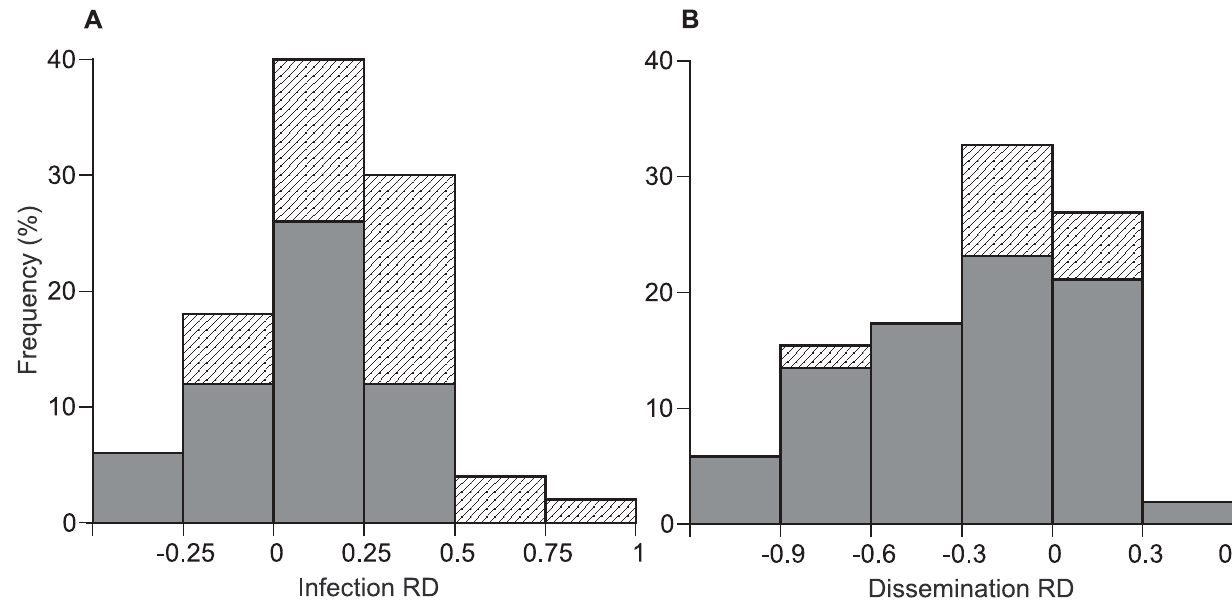
Figure 1. Distribution of RD among published experiments comparing the vector competence of Ae.albopictus and Ae.aegypti for horizontal transmission of DENV. Graphs show the overall frequency of differences in (A) the proportion of infected mosquitoes and (B) the proportion of mosquitoes with an infection disseminated from the midgut, as a function of the mosquito colonization history (i.e., number of generations spent in the laboratory before vector competence was assessed). Filled bars represent mosquitoes held # 5 generations in the laboratory; shaded bars correspond to mosquitoes colonized for . 5 generations. Negative RD values represent a reduced rate whereas positive values represent a greater rate for Ae. albopictus compared to Ae. aegypti .